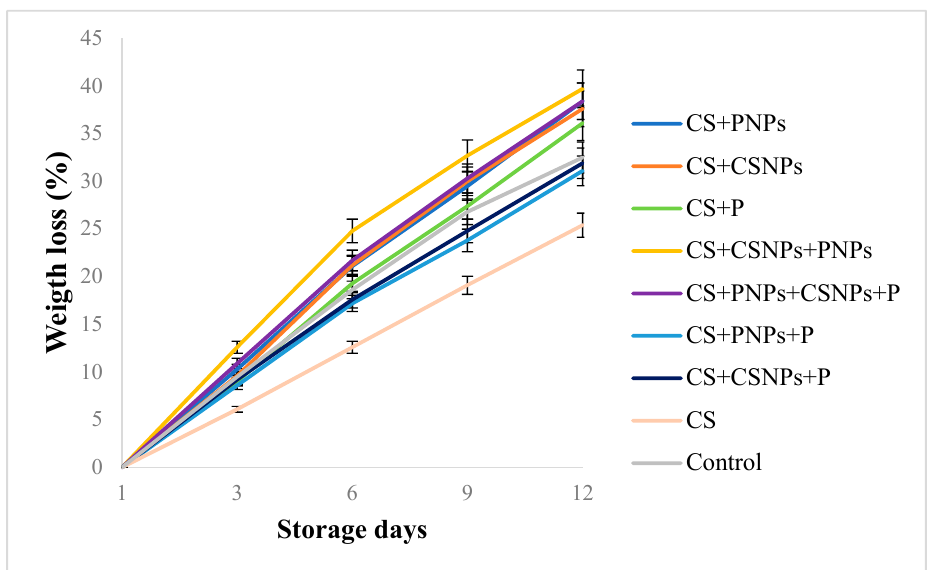
Figure 1. Effect of edible chitosan/propolis coatings on the weight loss of fig fruit stored for 12 days at 4 °C. CS (chitosan), P (propolis extract), CSNPs (chitosan nanoparticles), PNPs (propolis nanoparticles).